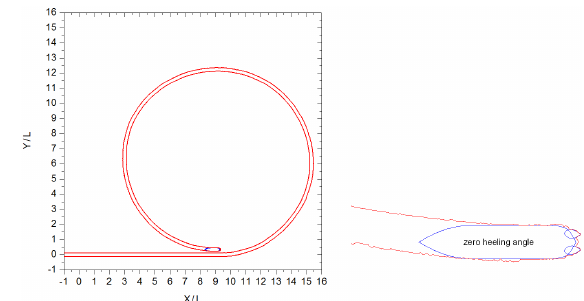
Figure 24: Simulated astern turning circle in 12 . 43 mm (0 . 3 m full-scale) level ice (power 120%, az- imuth angle 35 ◦ ). The turning circle is plot- ted with reference to ship length L